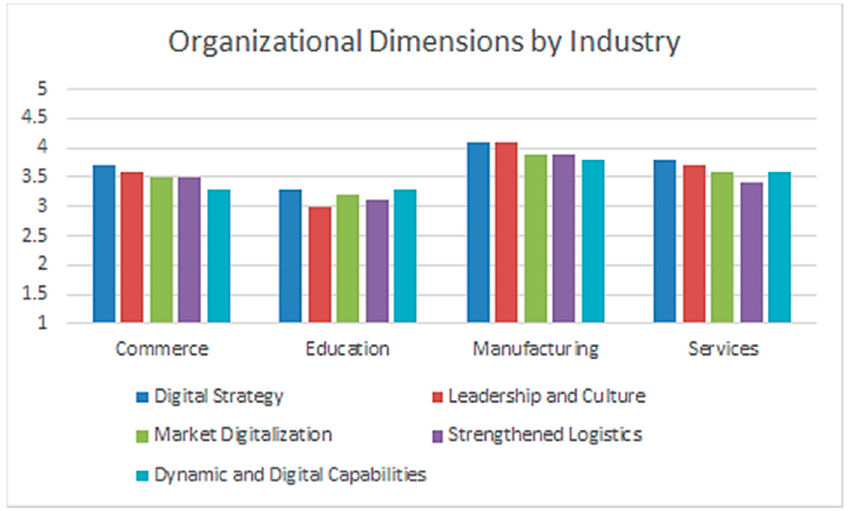
Figure 6. Organizational dimension gap analysis for education.